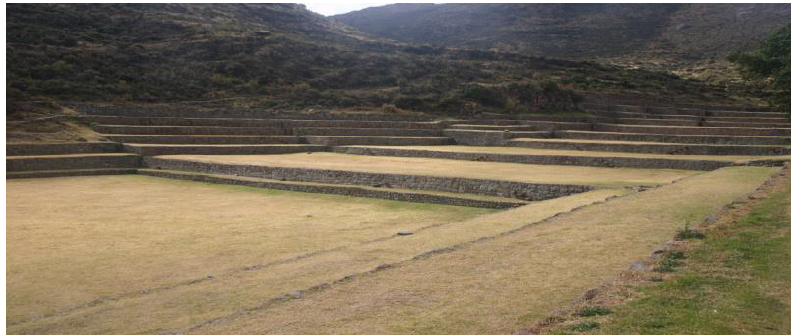
Figure 65. Thirteen agricultural terraces at Tipon. Photo by author.